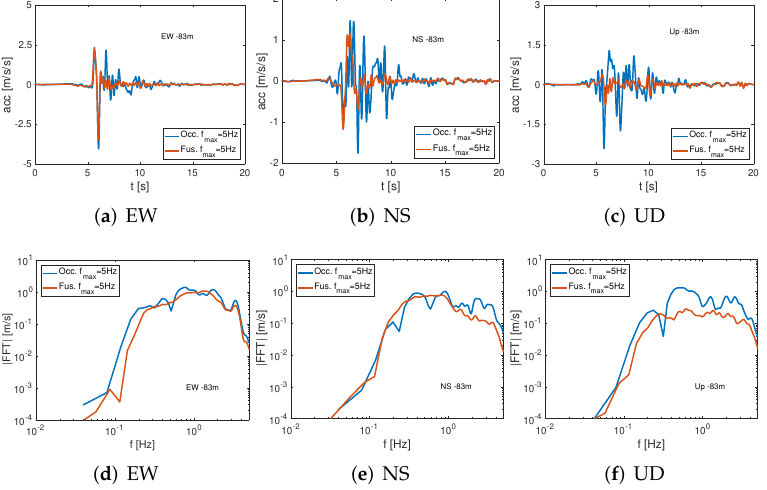
Figure 16. Synthetic acceleration time-histories ( a – c ) and Fourier’s spectra ( d – f ) filtered at 0–5 Hz at P3. Comparison between O2 (Occigen, blue) and F5 (Fusion,